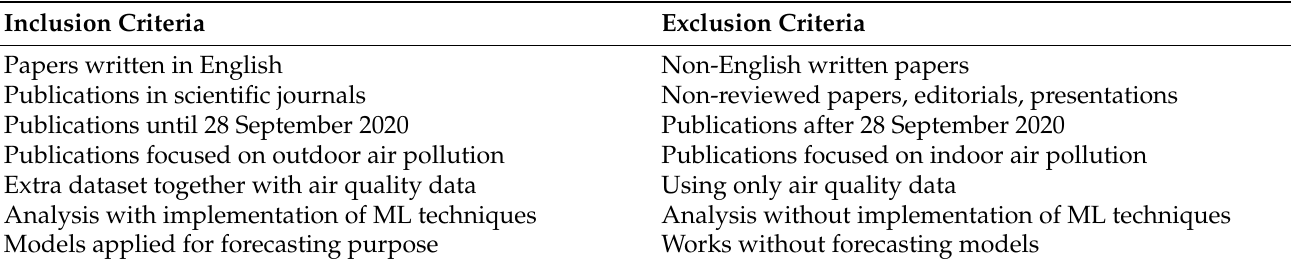
Table 1. Inclusion and exclusion